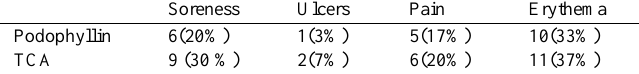
Table 2 : side effects of podophyllin and